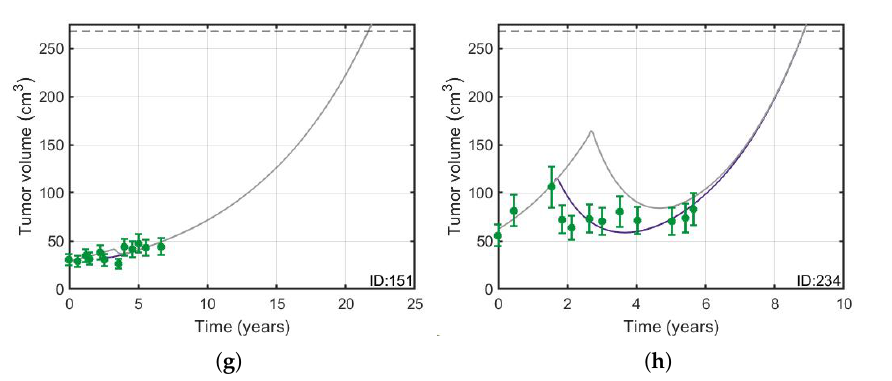
Figure 4. ( a – h ) Delaying radiotherapy does not have an effect on overall survival. RT was simulated to start one year later (gray solid line) than when actually received by the patient (solid purple line), except for patient 107, in whose case it was simulated to occur one year earlier. The horizontal black dashed line represents the fatal volume and the green circles, with their respective error bars, the longitudinal volumetric